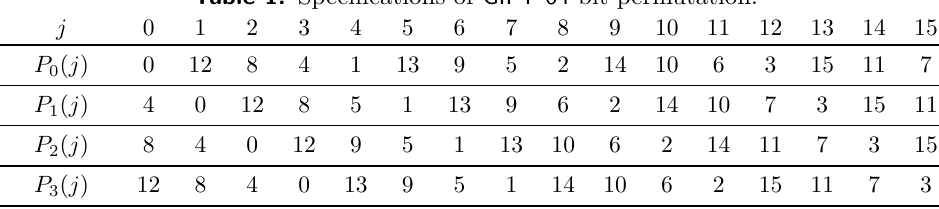
Table 1: Specifications of GIFT-64 bit permutation.